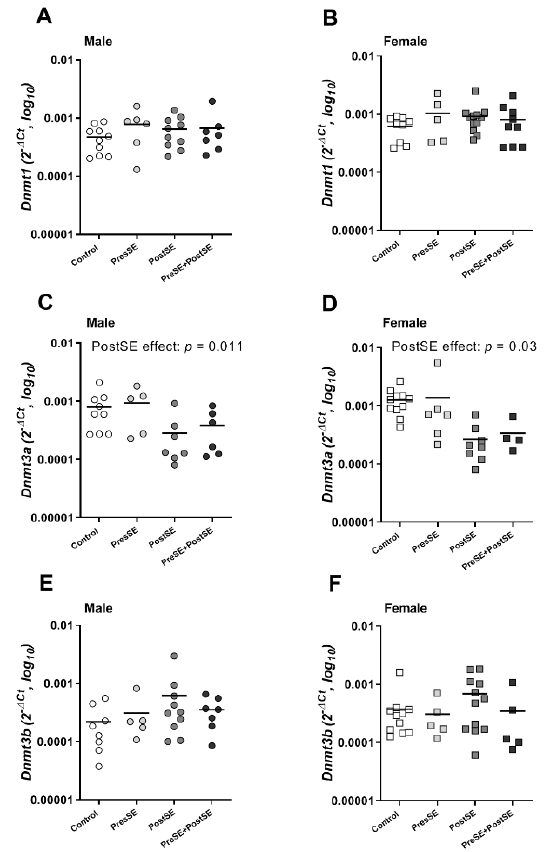
Figure 4. Dnmt1 , Dnmt3a and Dnmt3b mRNA expressions were measured inwhole liver from control, PreSE, PostSE and PreSE/PostSE offspring. Dnmt1 ( A , male and B , female), Dnmt3a ( C , male and D , female) and Dnmt3b ( E , male and F , female) mRNA were quantified by qRT-PCR analysis as described in Section 4. A linear regression analysis was performed among all groups. Circle ( ○ ) symbol(s) = male, square (□) symbol(s) = female. If not stated otherwise, the comparison of shown groups was not significant.